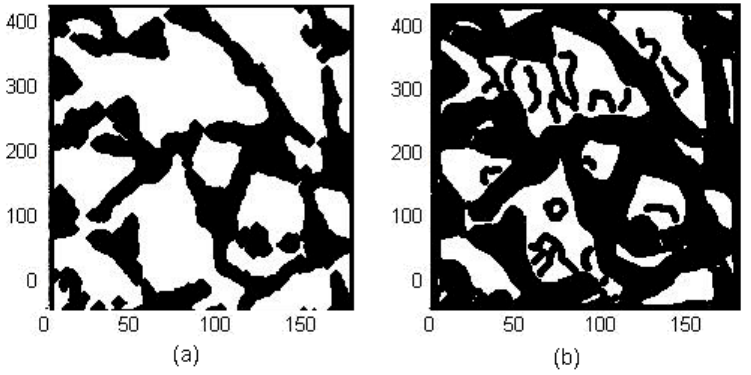
Figure 6. ( a ) Filled and eroded image; ( b ) binary image subtraction and Canny’s dilated edge.